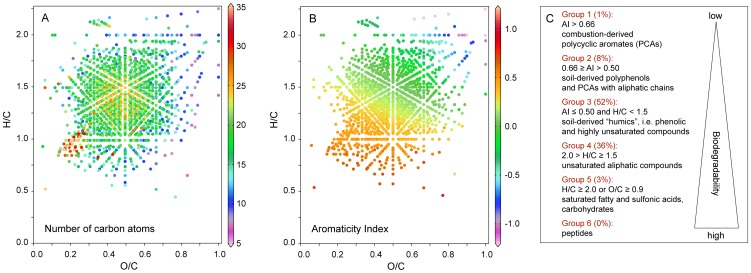
The molecular composition of dissolved organic matter in hail.The element ratio H/C is plotted as a function of O/C for each detected molecular formula detected by ultrahigh-resolution mass spectrometry (FT-ICR-MS) in at least one of the three hailstones. Each dot in these plots represents the molecular formula of an intact molecule. Panel A: The number of carbons in each molecular formula is displayed as a color code in the third dimension. Most compounds are large (C>10) and polar (O/C>0) and are likely not volatile. Panel B: The aromaticity index (AI-mod, [29]) of each molecular formula is displayed as a color code in the third dimension. An aromaticity index 0.5<AI is unambiguous evidence for aromatic compounds and an aromaticity index 0.66<AI is unambiguous evidence for condensed aromatics. Panel C: Compound groups were assigned to molecular formulae based on their aromaticity and element ratios [29], [39]. The biodegradability roughly increases from group 1 to group 6, e.g., polycyclic aromates are among the most stable compounds in the environment, whereas most peptides are quickly decomposed in the environment. Peptides (group 6) have the same characteristics as group 4, but contain nitrogen.